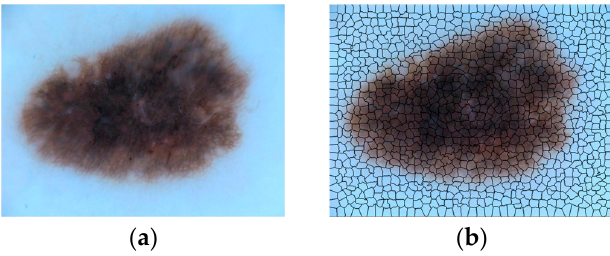
Figure 5. Example of superpixels. The original image ( a ) was subdivided into 996 pieces of superpixel areas ( b ) separated by black lines. The scale for the lesion image is 1022 pixels × 767 pixels.